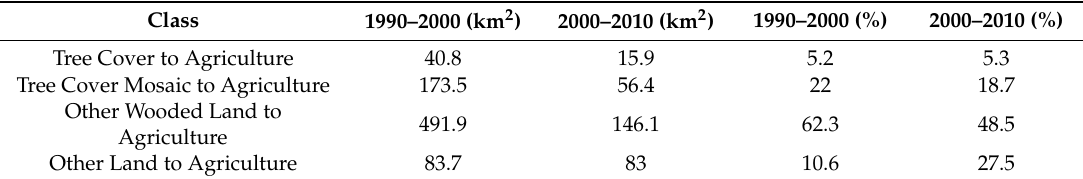
Table 5. Agricultural land cover changes in the buffer around UMNP. km 2 and % of total agricultural